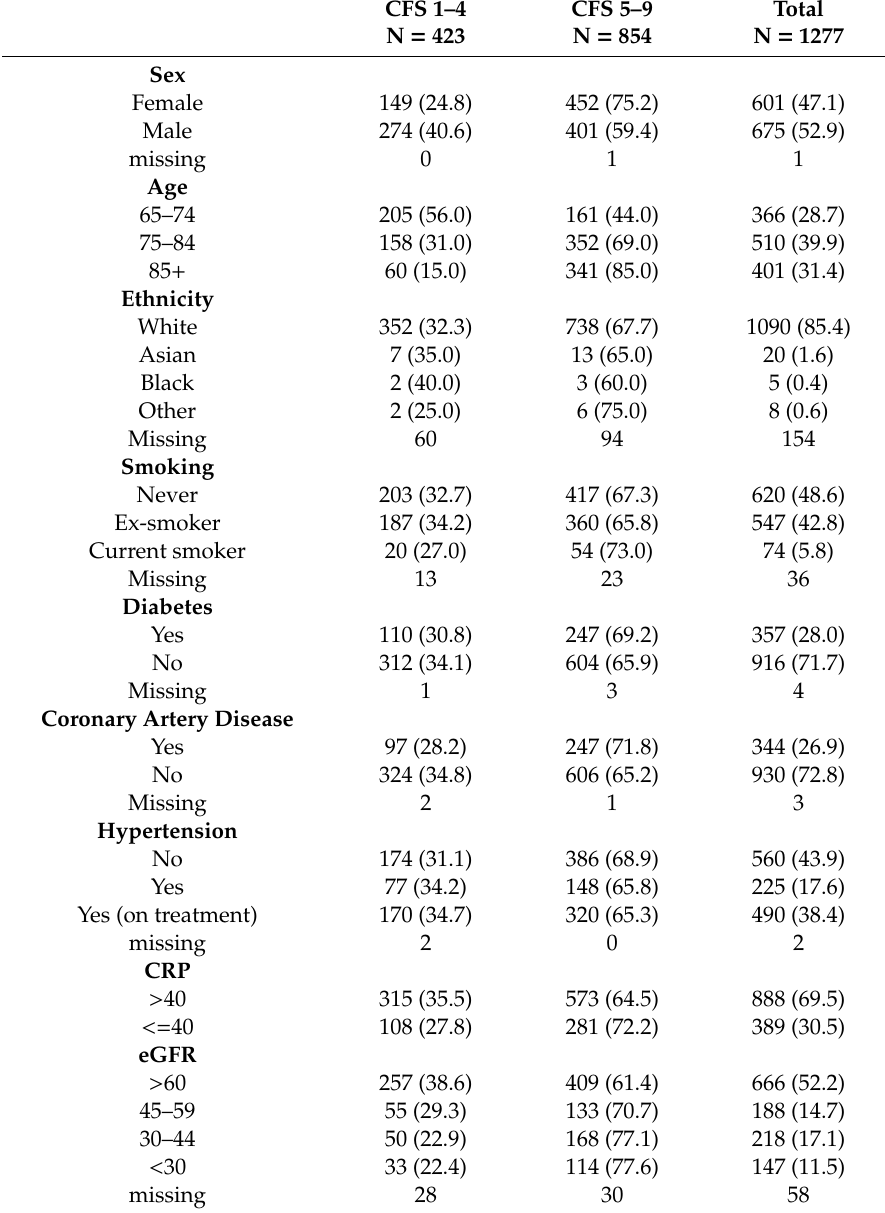
Table 1. Clinical Frailty Scale, demographics, and comorbidities in patients aged 65 or over admitted to 13 sites in UK and Italy—the COVID-19 in Older People (COPE)